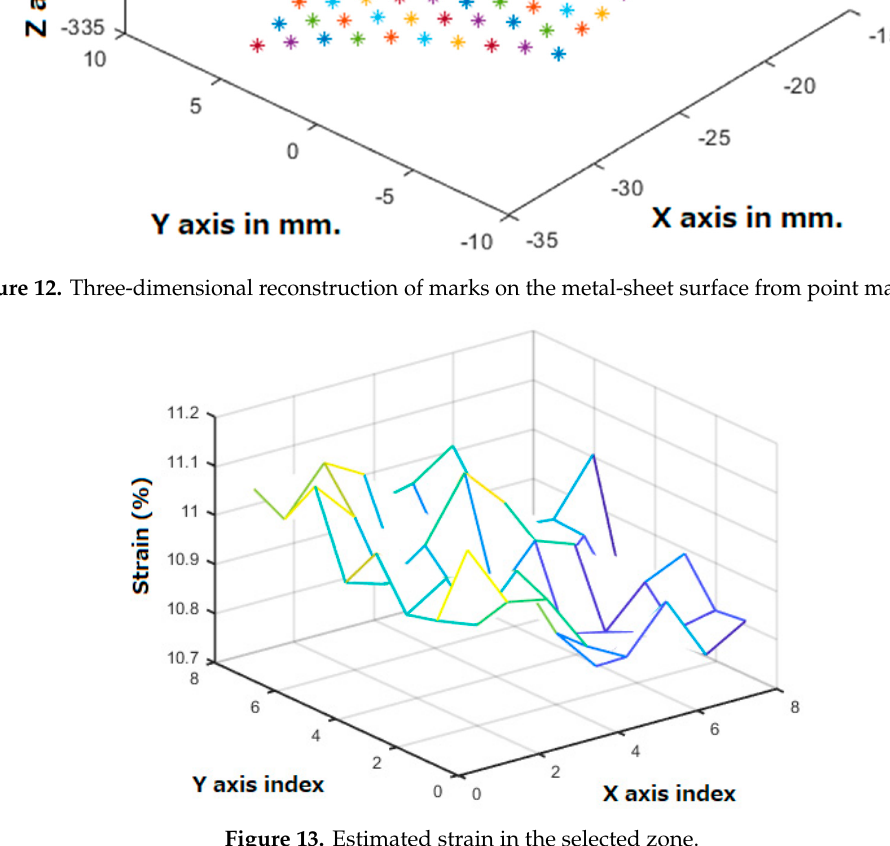
Table 2. Estimated strain (%) using the proposed method.